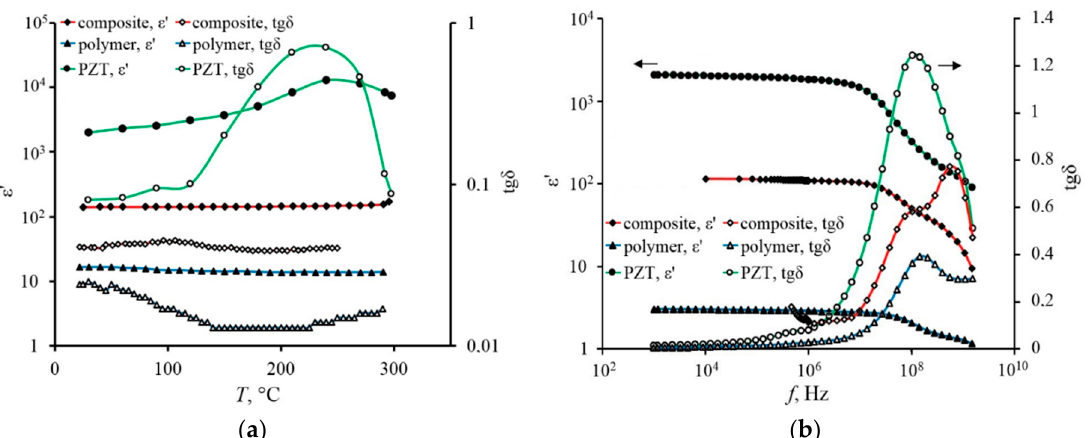
Figure 3. The temperature ( a ) and the frequency ( b ) dependences of ε′ and tg δ for PZT/polybenzoxazole composite (sample thickness is 13.5 µm; volume fraction of the PZT filler is about 35%) and its components: polymer (polybenzoxazole) and PZT ceramic.